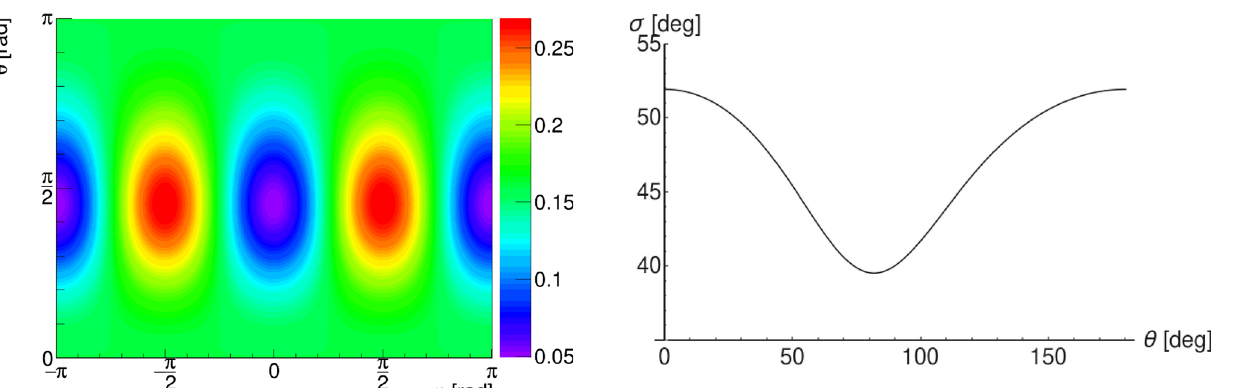
Fig. 6 Standard deviation σ of the probability density distribution (4) as a function of θ for 511 keV-photons. The minimum is 40 ◦ for a scattering angle of 81 . 66 ◦ and the maximum (52 ◦ ) for small or large scattering